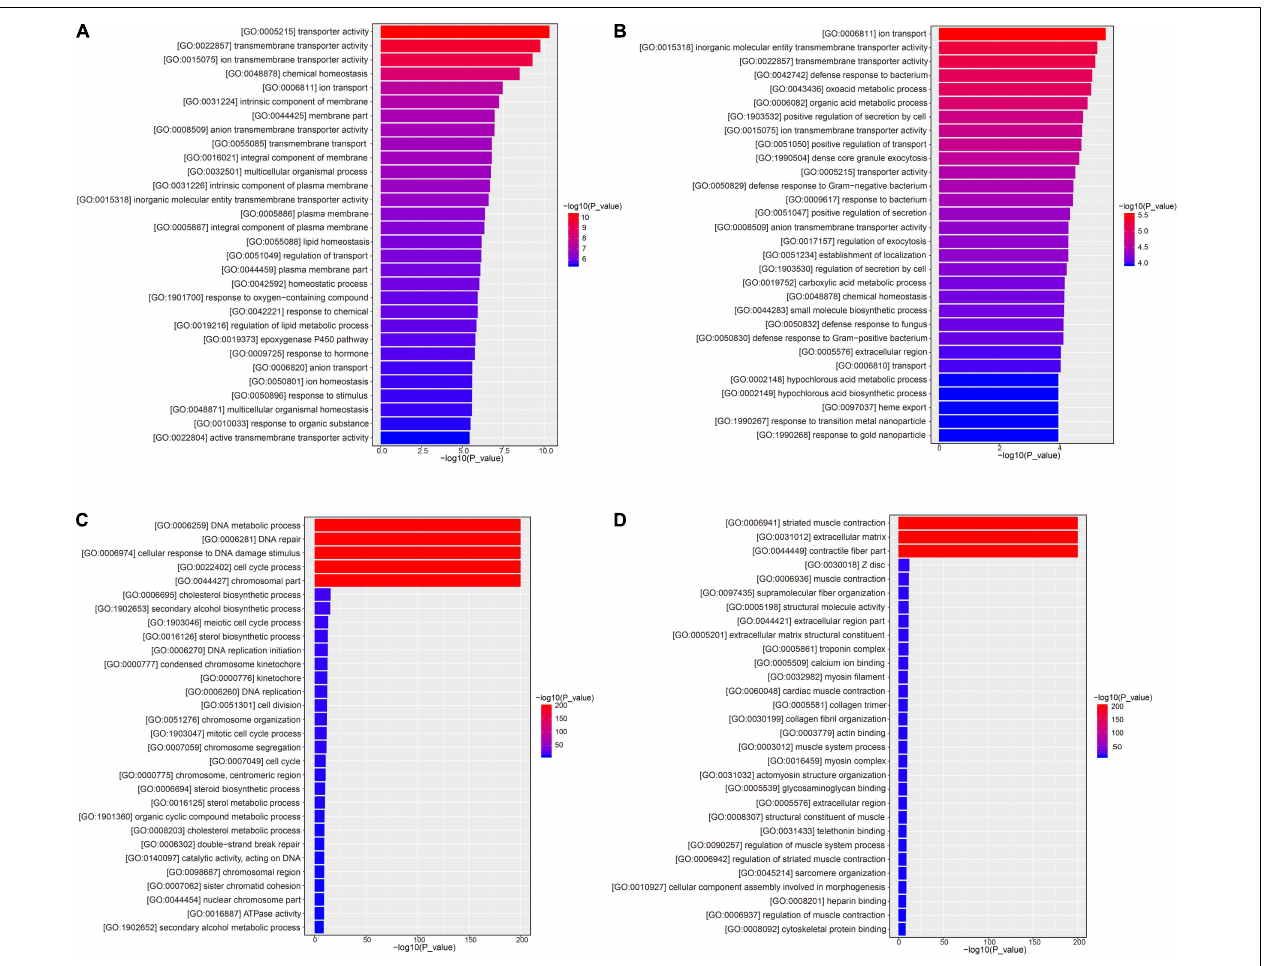
FIGURE 6 | Bar plot of GO function enrichment of DEGs. (A) RSHG versus RCG bar plot of up-regulated DEGs; (B) RSLG versus RCG bar plot of up-regulated DEGs; (C) RSHG versus RCG bar plot of down-regulated DEGs; and (D) RSLG versus RCG bar plot of down-regulated